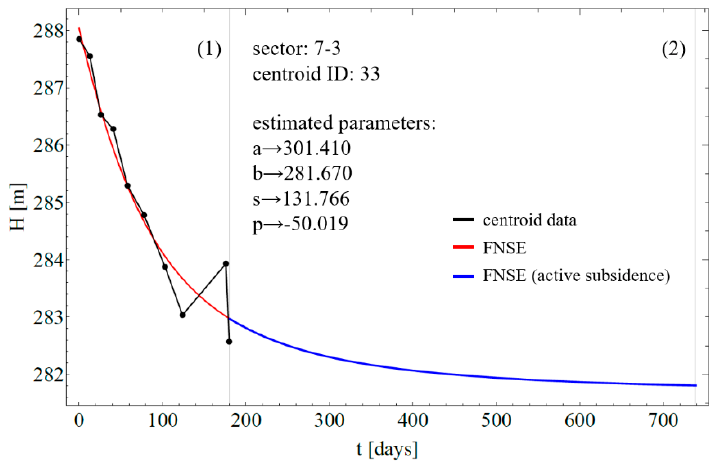
Figure 15. Centroid C 33 height in each epoch (color black), fitted FNSE model to the centroid data (color red), extrapolated values of the fitted model (color blue)—active subsidence.